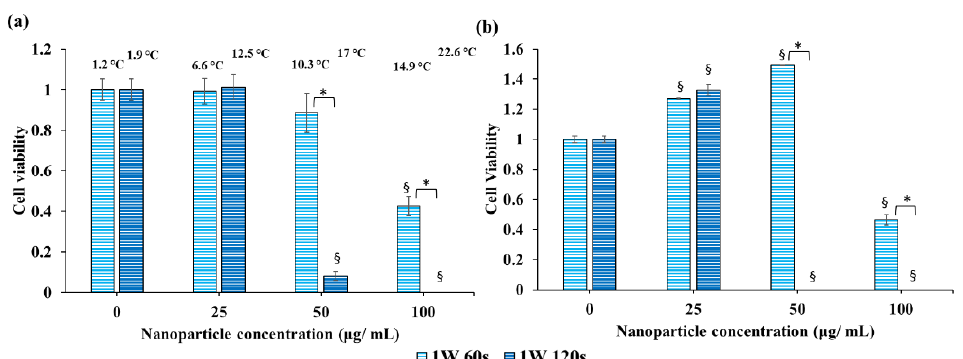
Figure 4. Cell viability of CT-26 cells following photothermal ablation induced by exposure to extracellular VMWNPs, and infrared stimulation for ( a ) OxS and ( b ) OxR cells. The values above the columns indicate the maximum temperature change. § indicates statistical significance compared to the control (0 µg/mL VMWNPs) ( p < 0.05). * Indicates statistical significance between 60 and 120 s ( p < 0.05).